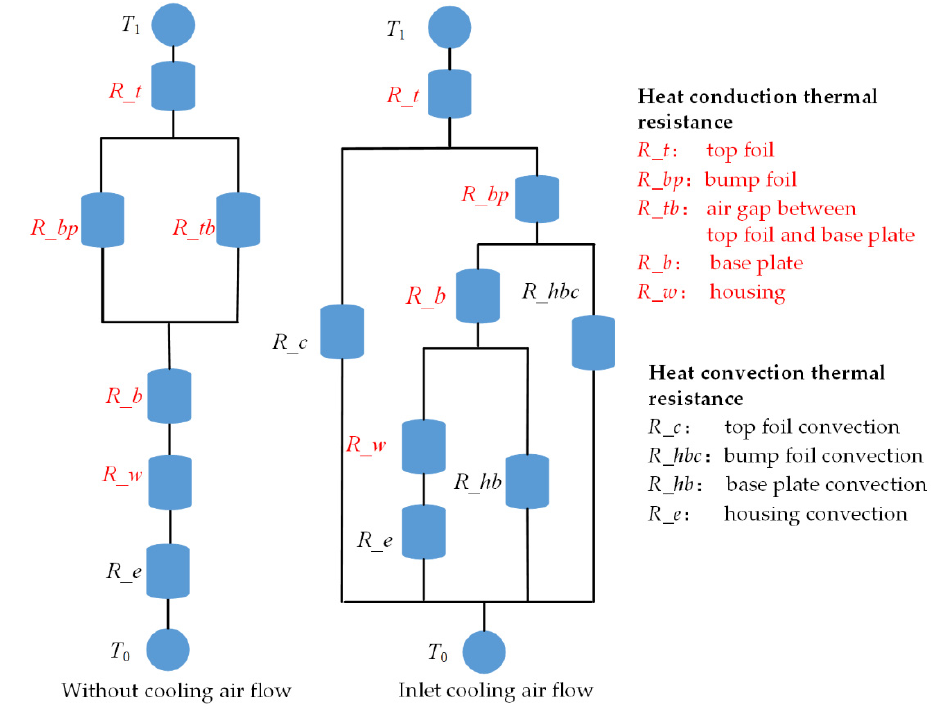
Figure 5. Equivalent thermal resistance model diagram.